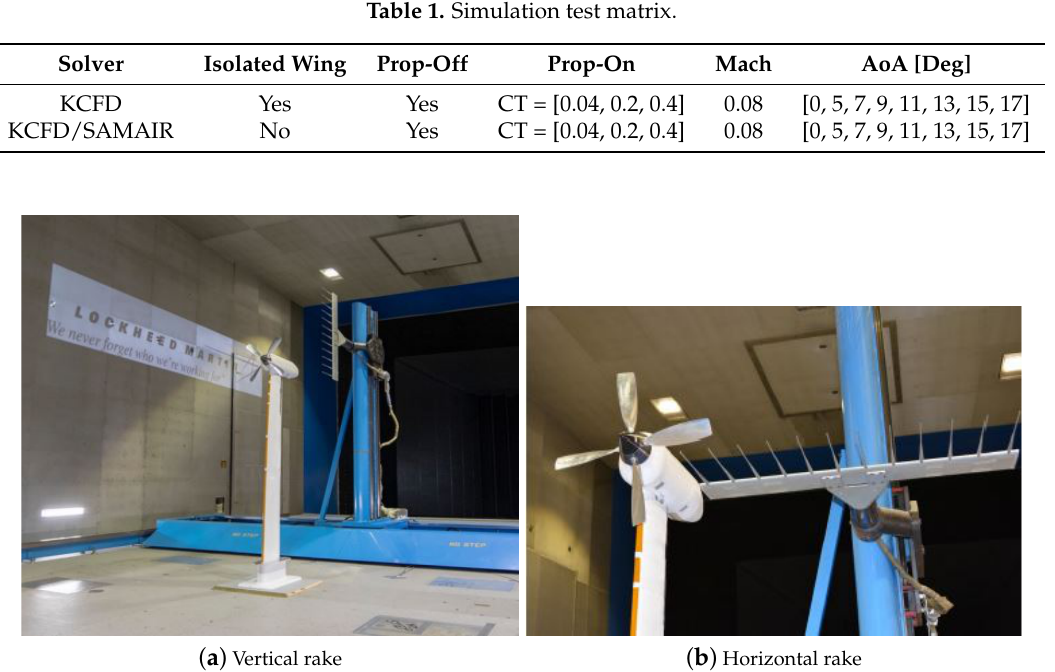
Figure 2. Wind tunnel setup and wake survey behind the propeller